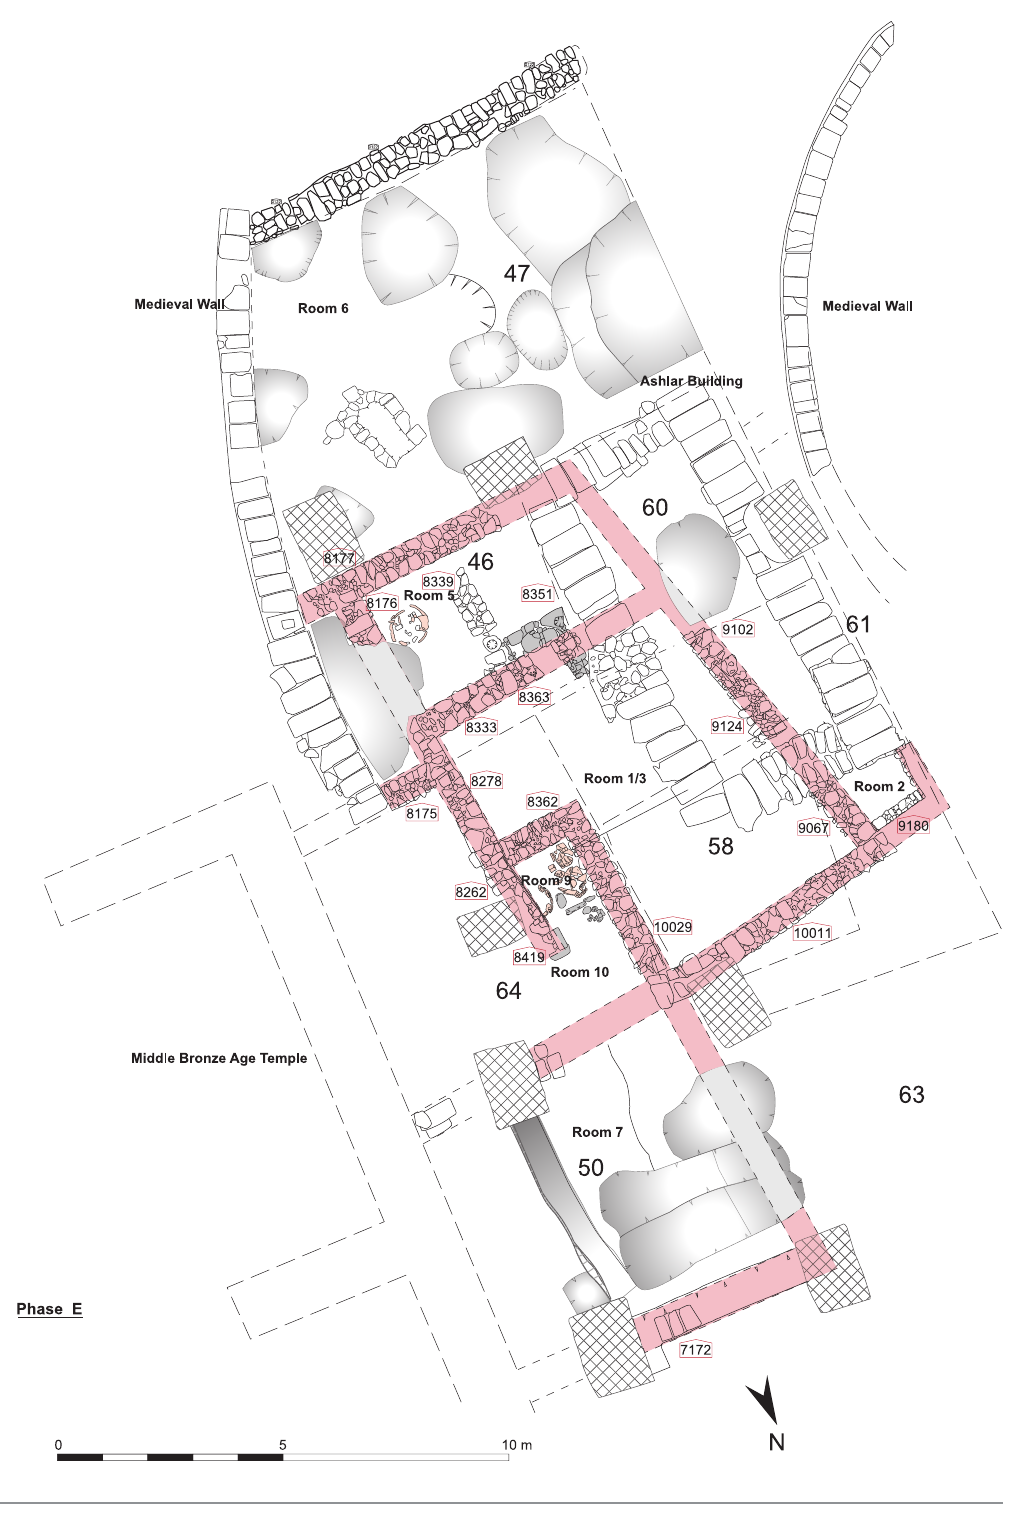
Fig 3. The Temple, Phase